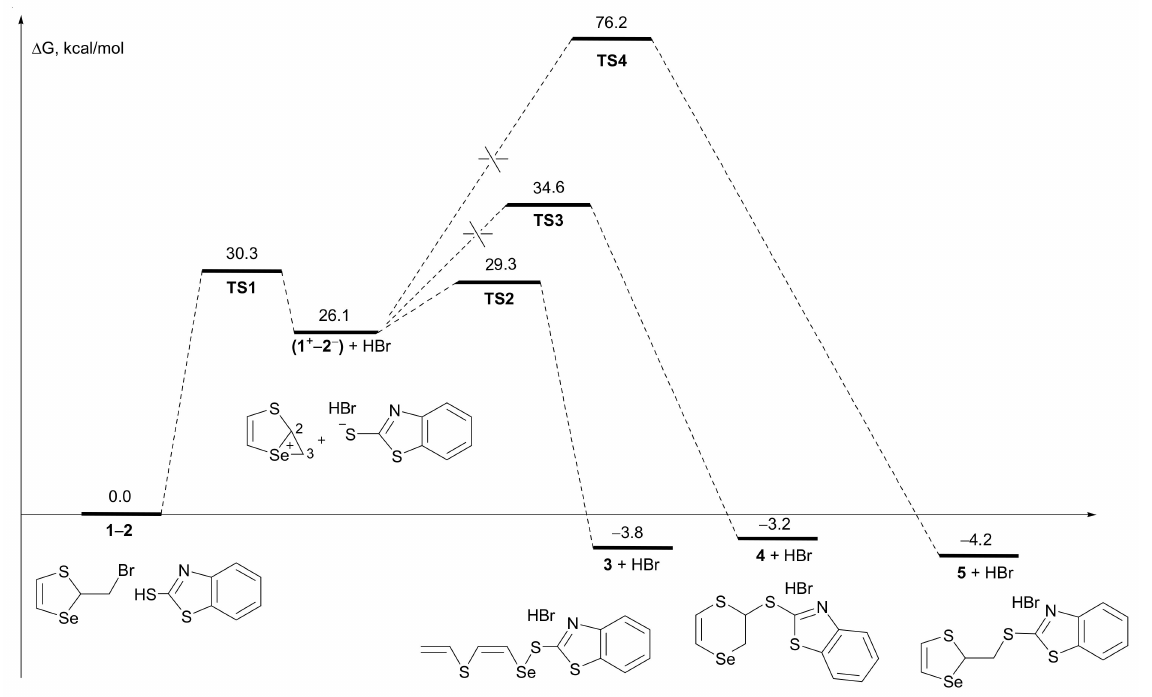
Figure 2. Schematic representations of processes of the formation of selanyl sulfide 3 , six-membered product 4 , and five-membered heterocycle 5 according to B3LYP/6-311 +